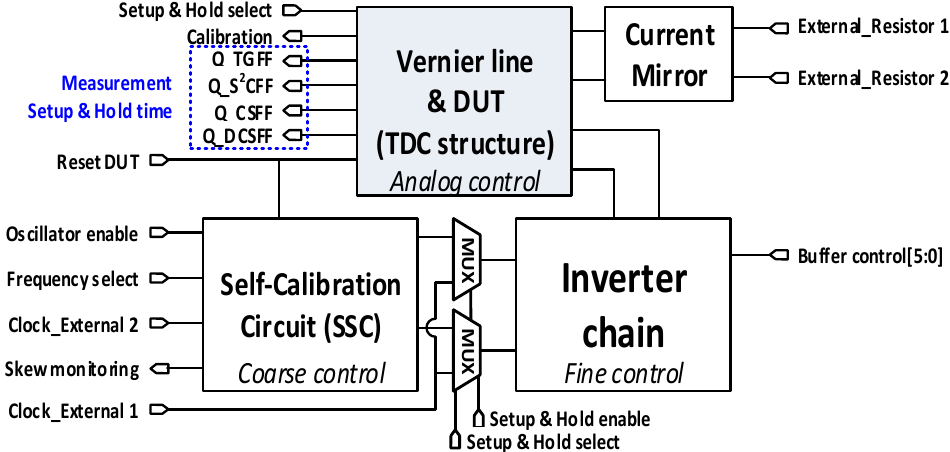
Figure 9. Block Diagram for Setup and Hold Time Measurement.